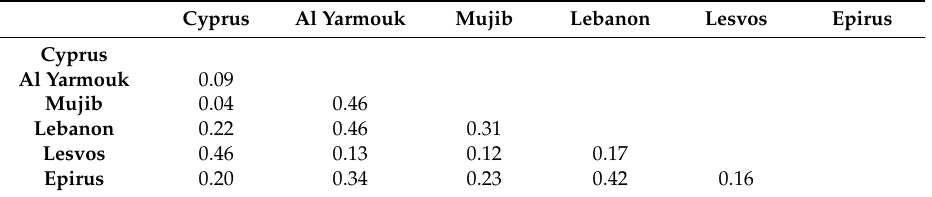
Table 2. Landscape Types similarity among study sites based on Sørensen similarity